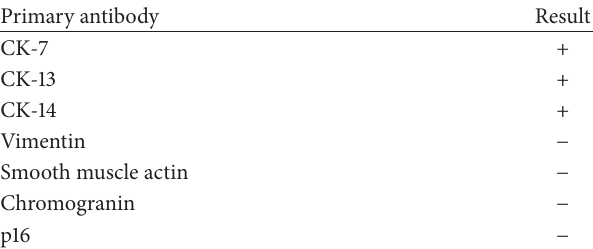
Table 2: Immunohistochemistry